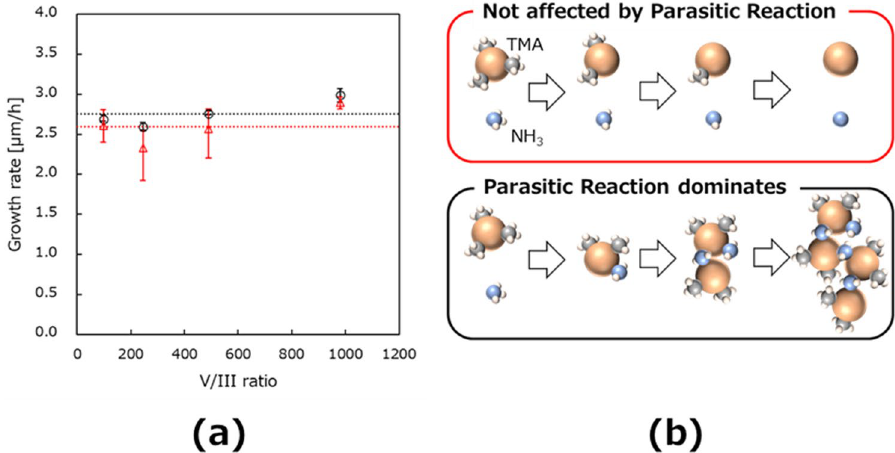
Figure 2. Confirmation of reduction in parasitic reactions during growth. ( a ) The growth rate of the second AlN layer with various V/III ratios (98, 245, 490 and 980). The dotted line represents a guideline for assuming the same growth rate. ( b ) The mechanism of decreasing AlN growth rate 11,15,16